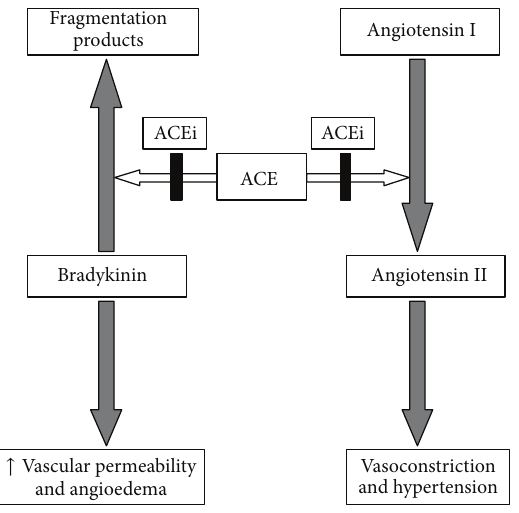
Figure 3: Mechanism of ACEi-induced angioedema.